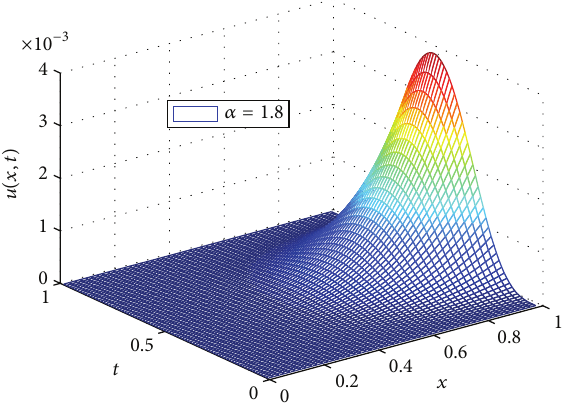
Figure6:Theanalyticalsolutionsurfacewhen 𝛼 = 1.8 inExample